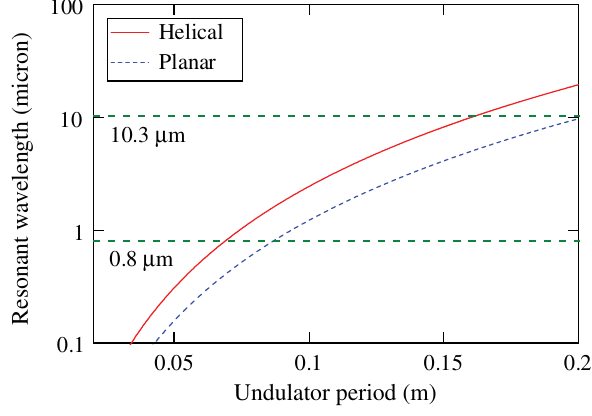
FIG. 1. Resonant energy scaling for fixed magnetic field